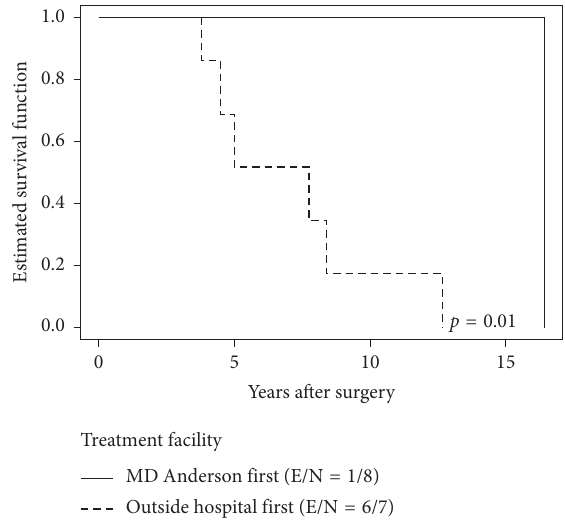
Figure 4: Recurrence-free survival by initial treatment center. Of the 8 patients that recurred during the follow-up period, 7 received initial care at outside facility first (nonsarcoma center), highlighting the importance of definitive treatment by sarcoma specialists.